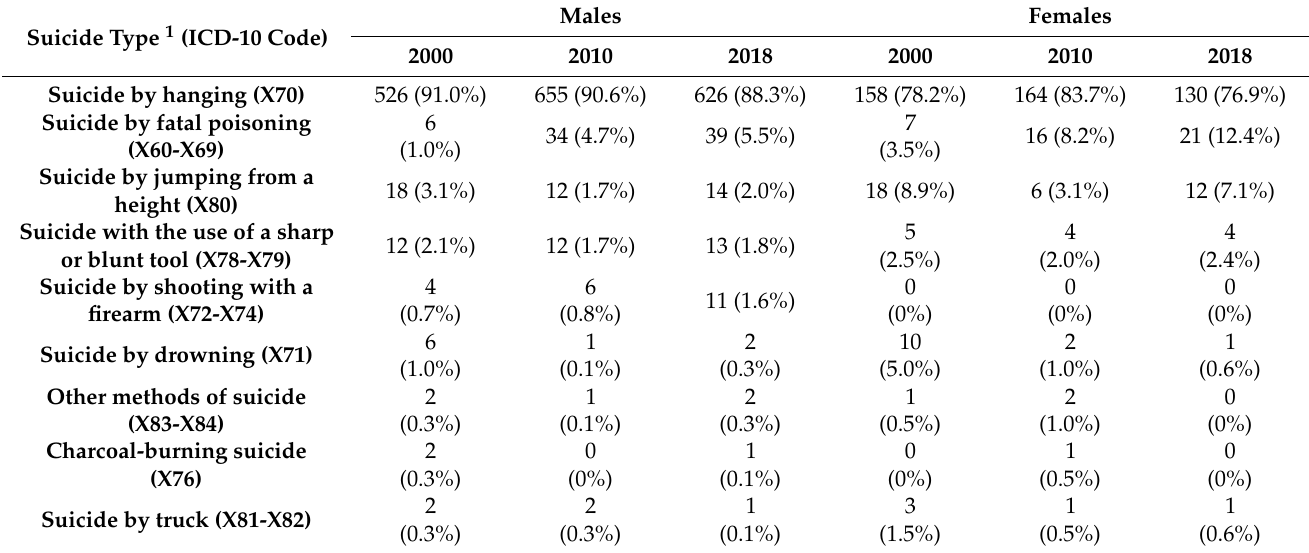
Table 3. Suicide method in adults aged 65 or older by type and